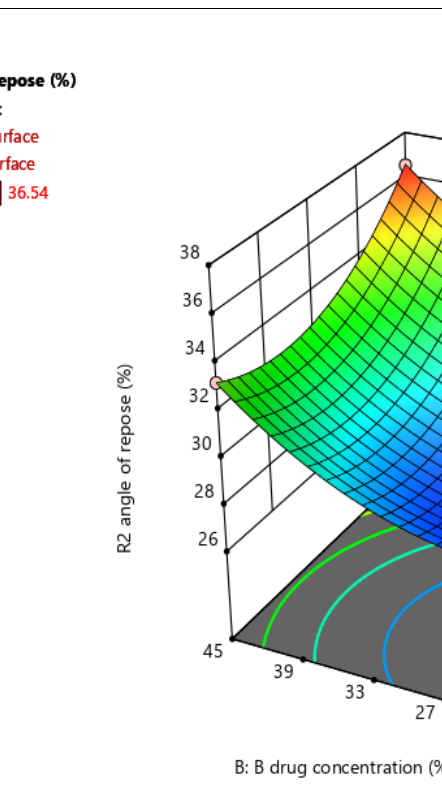
Table 4. Evaluation of liquisolid compacts of